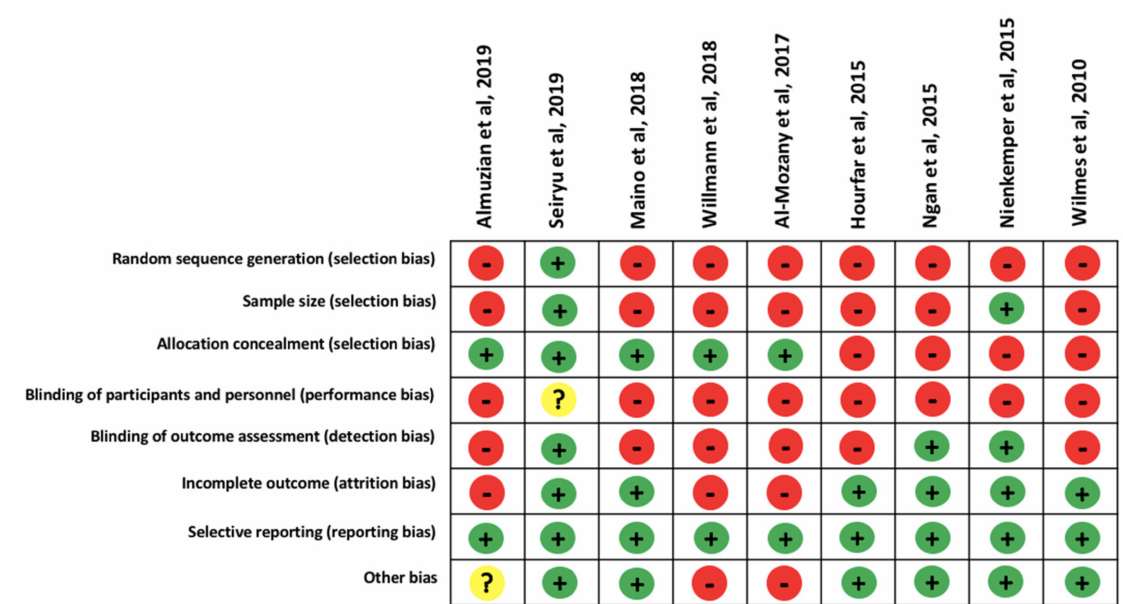
Figure 1. Risk of bias assessed according to